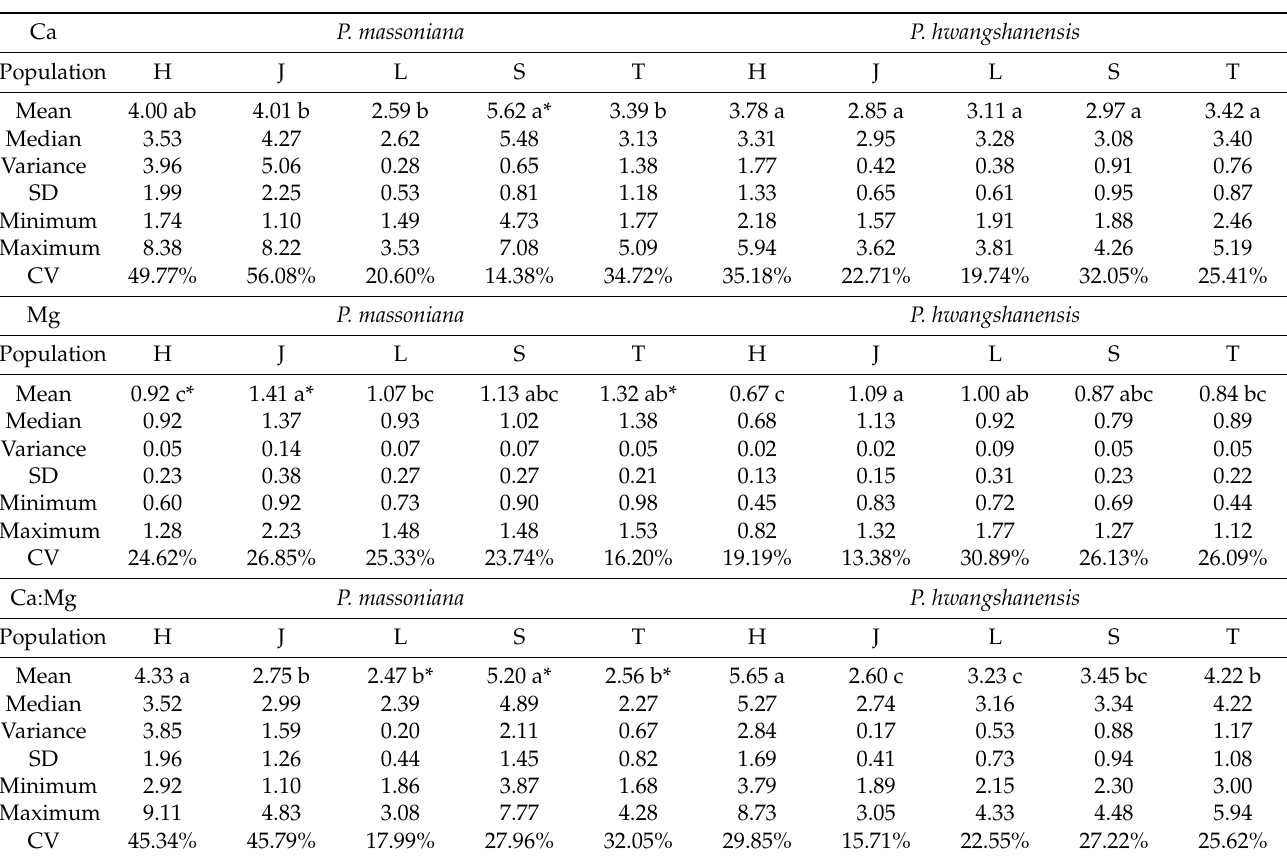
Table 1. Ca and Mg concentrations in the needles of P. massoniana and P. hwangshanensis among populations (mg · g − 1